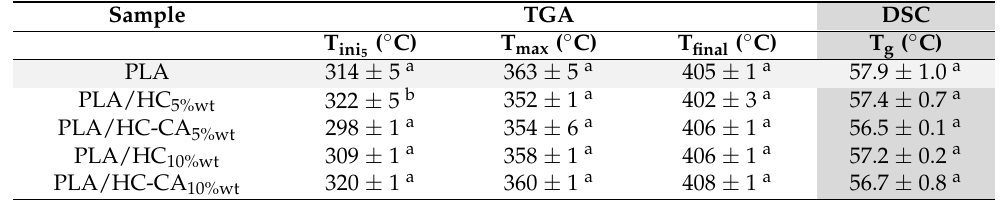
Figure 11. TGA representative thermograms of the studied PLA-based films. In the yellow box a zoomed region, highlighting T ini5 differences, is reported. Thermograms were processed using OriginPro 2015 software. Table 3. Thermal parameters obtained for HC-CA and non-functionalized hemp cellulose (HC) (values are expressed as mean ± SD, n = 3). Different superscripts in the same column refer to statistically different values ( p <